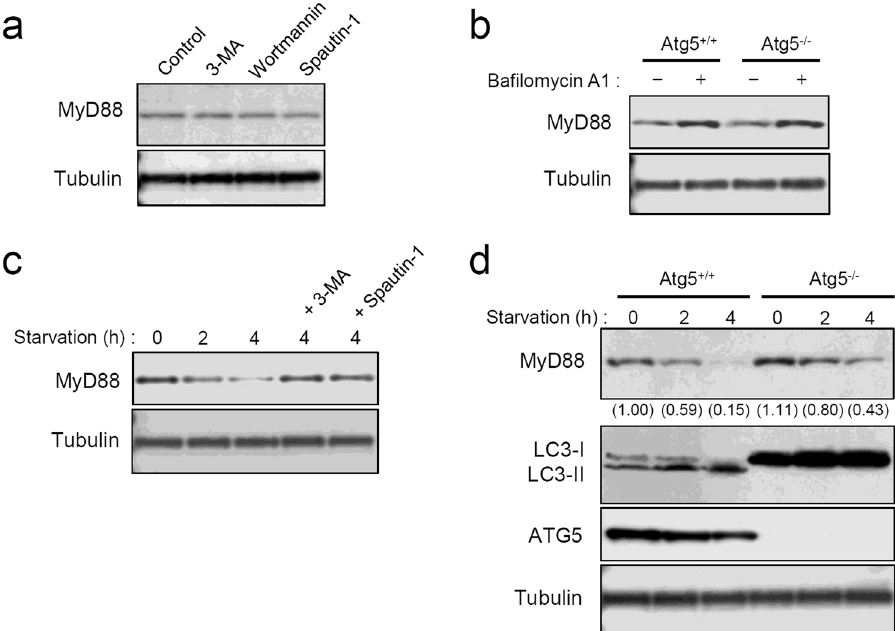
Figure 4. Basal autophagic degradation of MyD88 is mediated by a mechanism different from macroautophagy. ( a ) Treatment with the inhibitors of macroautophagy does not affect basal MyD88 expression. MEFs were incubated with 0.5% DMSO (control), 10 mM 3-MA, 100 nM wortmannin, or 10 μ M spautin-1 for 12 h. Expression levels of MyD88 and α -tubulin were assessed by immunoblotting. All the blots were obtained under the same experimental conditions, and the cropped images of the blots are shown. The uncropped images are in Supplementary Fig. 20. ( b ) Deficiency in ATG5 does not affect BafA1 treatment-increased basal MyD88 expression. Atg5 + / + MEFs and Atg5 − / − MEFs were incubated with 0.5% DMSO (BafA1 − ) or 100 nM BafA1 (BafA1 + ) for 12 h. Expression levels of MyD88 and α -tubulin were assessed by immunoblotting. All the blots were obtained under the same experimental conditions, and the cropped images of the blots are shown. ( c ) Starvation-induced degradation of basal MyD88 is suppressed by the inhibitors of macroautophagy. MEFs were incubated with or without 10 mM 3-MA or 10 μ M spautin-1 for 6 h, and then cultured under the starvation conditions for the indicated periods. Expression levels of MyD88 and α -tubulin were assessed by immunoblotting. All the blots were obtained under the same experimental conditions, and the cropped images of the blots are shown. ( d ) Starvation-induced degradation of basal MyD88 is affected by ATG5 deficiency. Atg5 + / + MEFs and Atg5 − / − MEFs were cultured under the starvation conditions for the indicated periods. Expression levels of MyD88, LC3, ATG5, and α -tubulin were assessed by immunoblotting. Values within parentheses represent the ratio determined by densitometric measurement of the bands. All the blots were obtained under the same experimental conditions, and the cropped images of the blots are shown. The uncropped images are in Supplementary Fig.